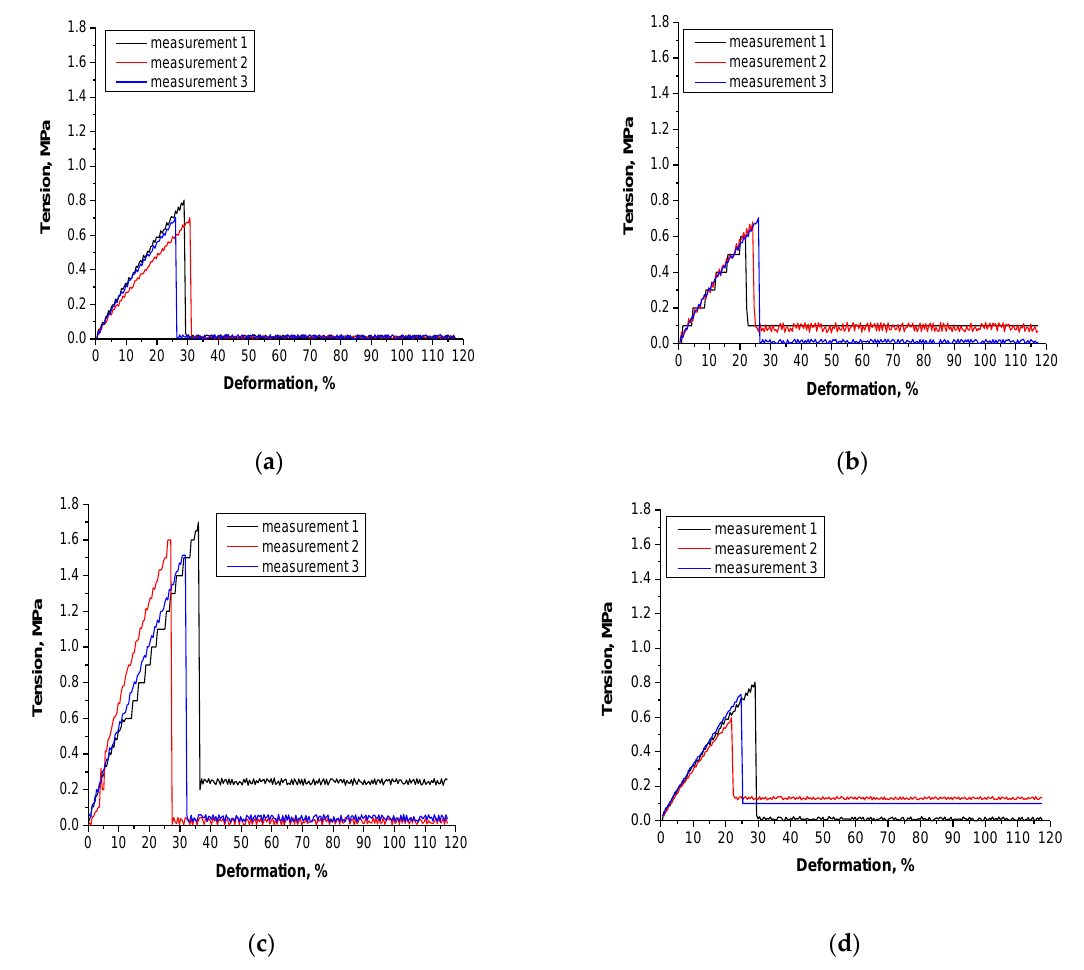
Figure 11. Results of tensile strength analysis of sample 0/1.6 ( a ), 0/3.2 ( b ), 9/1.6 ( c ) and 23/3.2 ( d ). Deformation of hydrogel samples under selected tension as well as maximum deformation under which sample has broken are indicated in Table 3. Table 3. Deformation of samples under selected tension and the maximum deformations.